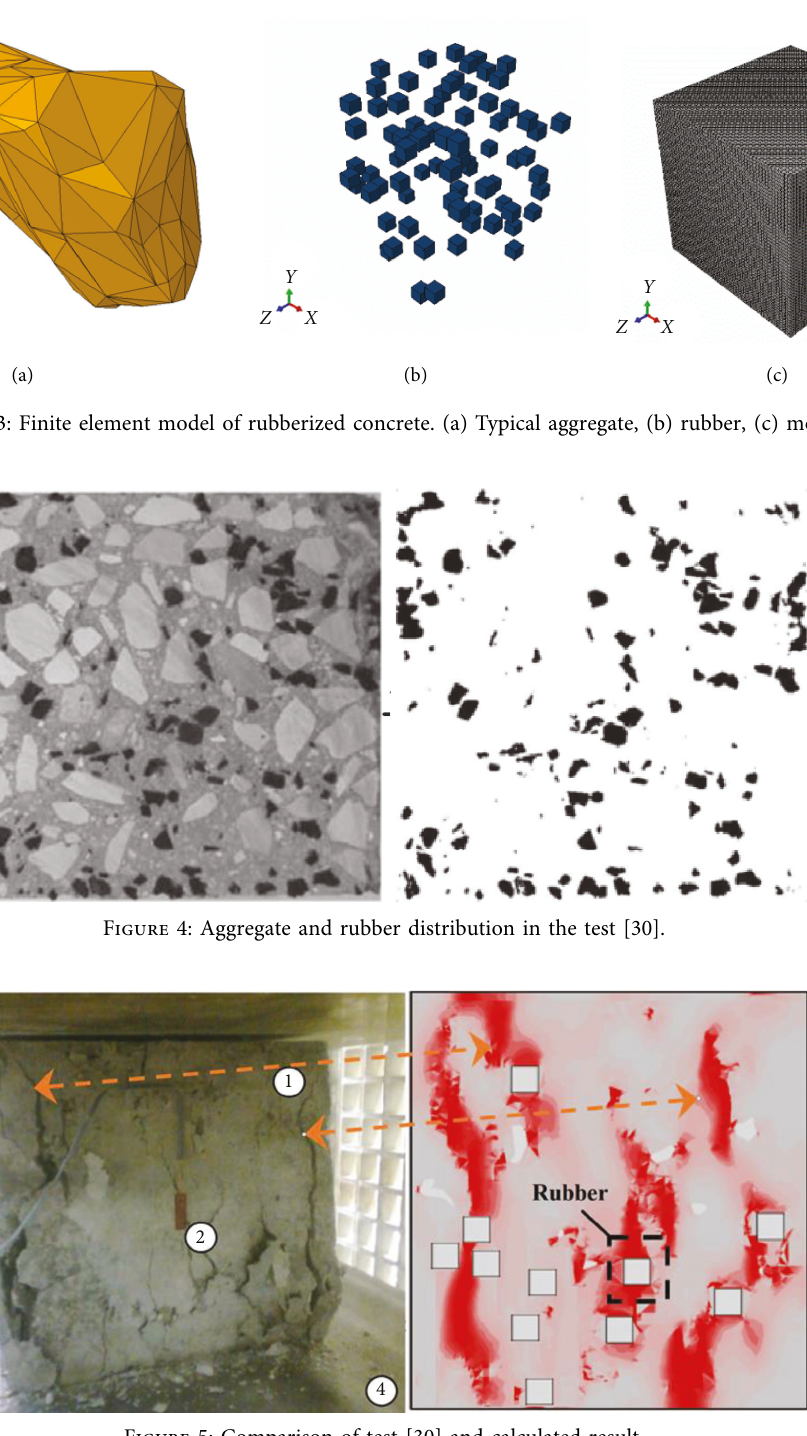
Figure 5: Comparison of test [30] and calculated result.